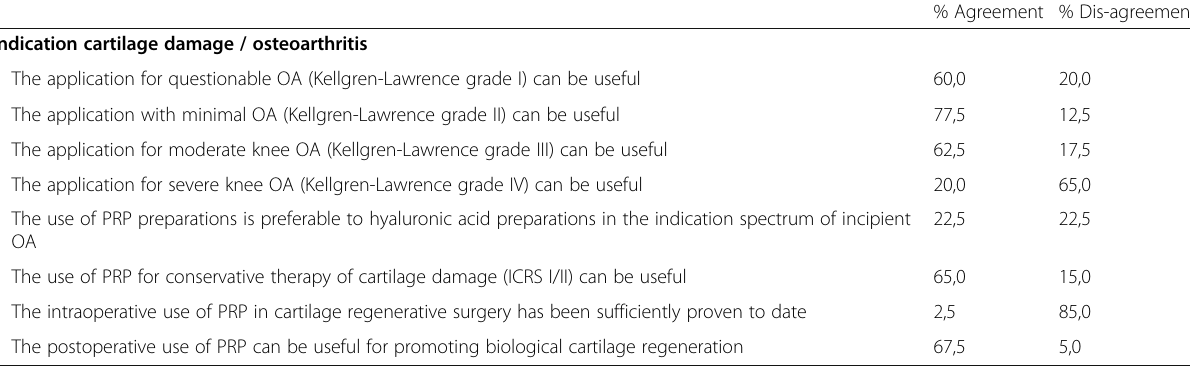
Table 1 Indications for use of PRP in cartilage damage and